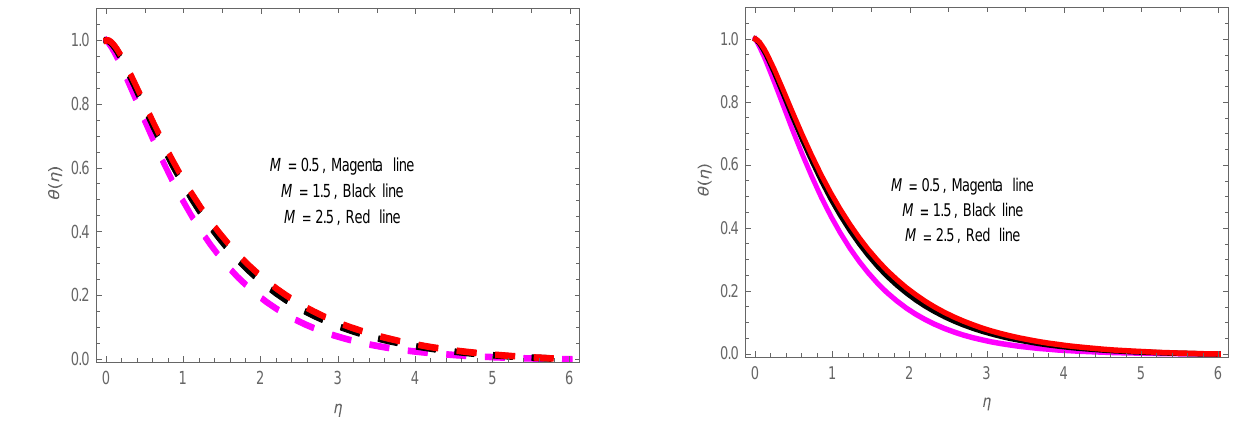
Figure 8. 𝜃(𝜂) for dissimilar values of 𝜙 1 𝑎𝑛𝑑 𝜙 2 .